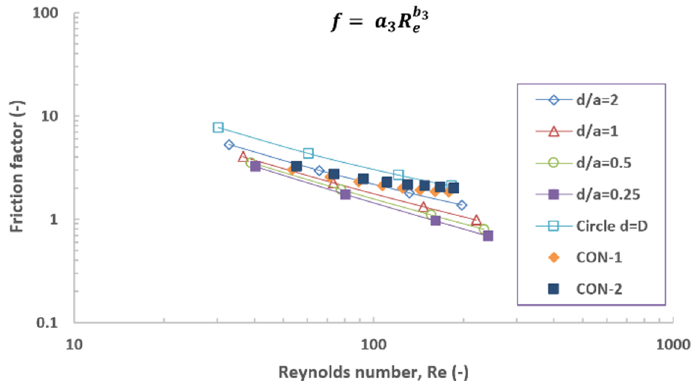
( d ) Figure 8. Contours of velocity in the main flow direction for the super velocity of 0.04 m/s (red: high, blue: low). ( a ) d / a = 2; ( b ) d / a = 1; ( c ) d / a = 0.5; ( d ) d / a = 0.25. 3.2. Friction Factor and the Dimensionless Power Number The pressure drop in the SW membrane channel directly reduces the total transmembrane pressure that acts on the membrane surface. A driven pump has to maintain the transmembrane pressure; so, in the separation process, higher energy is required to compensate for the energy loss influenced by the pressure losses. To make comparisons across different feed spacer situations, the pressure drop can be expressed in terms of the friction factor. The friction factor is commonly employed as a dimensionless parameter to find the changing inclination for different Reynolds numbers. The relationship is presented as the following equation,  = (  ). (8) Figure 9 shows the friction factor generated by the feed spacer with different connecting filament diameters and different Reynolds numbers. Table 2 lists the results reported in the study by Schock et al. [2]. The pressure drop increased when the Reynolds number increased, but the friction factor decreased when the Reynolds number increased. As the connecting filament diameter decreased (the channel porosity was increased), the flow cross-section of the channel obstructed by the feed spacer decreased. The pressure drop and friction factor values were higher when the porosity was low. The friction factor decreased when the porosity increased; however, the amplitude gradually became smaller, as shown in Figure 7. Moreover, from the contours of total pressure shown in Figure 10, the higher filament diameter generated a higher friction factor linked to the filament drag, and this was described as the drag coefficient in previous studies [45,46]. Moreover, the Haaksman et al.